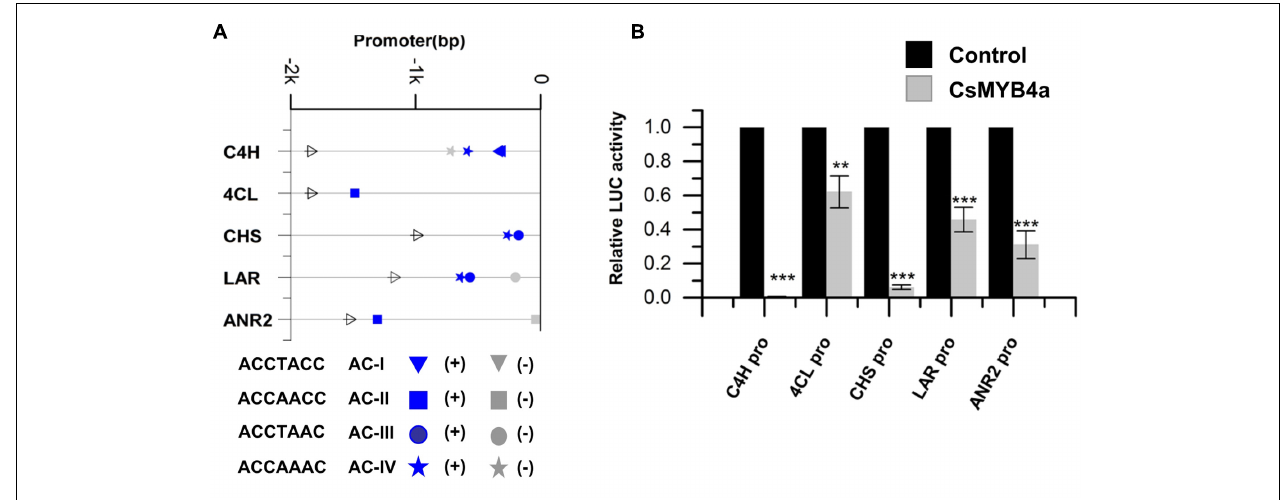
FIGURE 3 | CsMYB4a repressed the promoter activity of genes involved in the phenylpropanoid and flavonoid biosynthesis pathways. (A) Distribution of the four classes of AC-elements in the promoters of genes involved in phenylpropanoid and flavonoid biosynthesis pathways in tea plants. Sense elements and anti-sense elements are represented in blue and gray, respectively. (B) Dual luciferase (LUC) assays of CsMYB4a (effector) and the promoters fused to firefly luciferase (reporter). Empty vector was used as the effector in the control assay. The promoters of C4H , 4CL , CHS , LAR , and ANR2 genes were used in dual luciferase assays ( n = 3, ∗ P < 0.05, ∗∗ P < 0.01, ∗∗∗ P < 0.001).